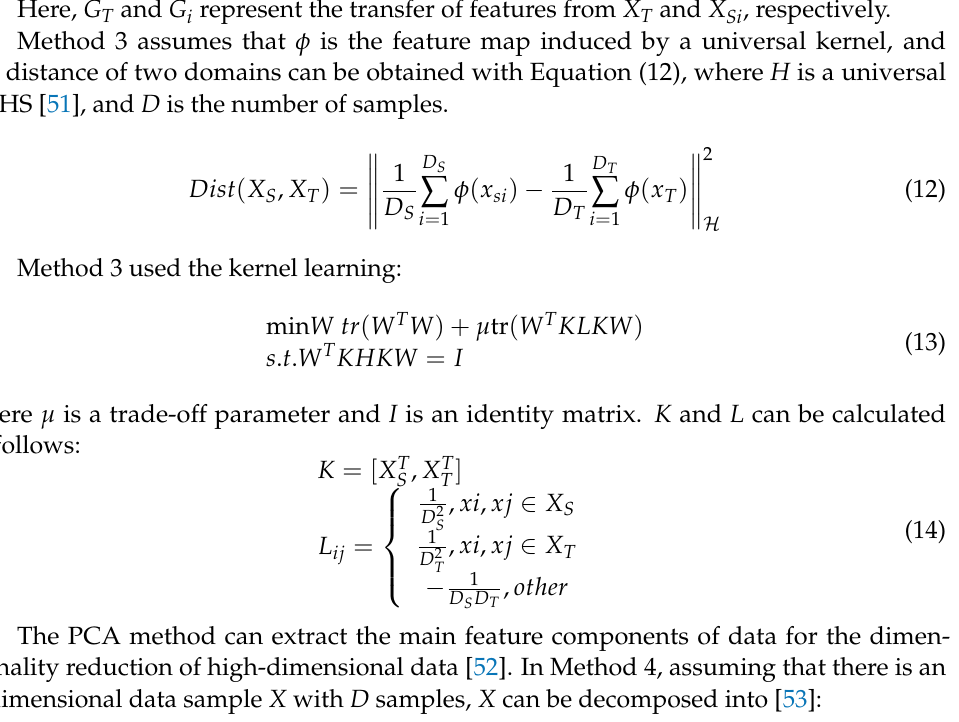
Figure 6. Implementation of Method 4. Here, G T and G i represent the transfer of features from X T and X Si ,